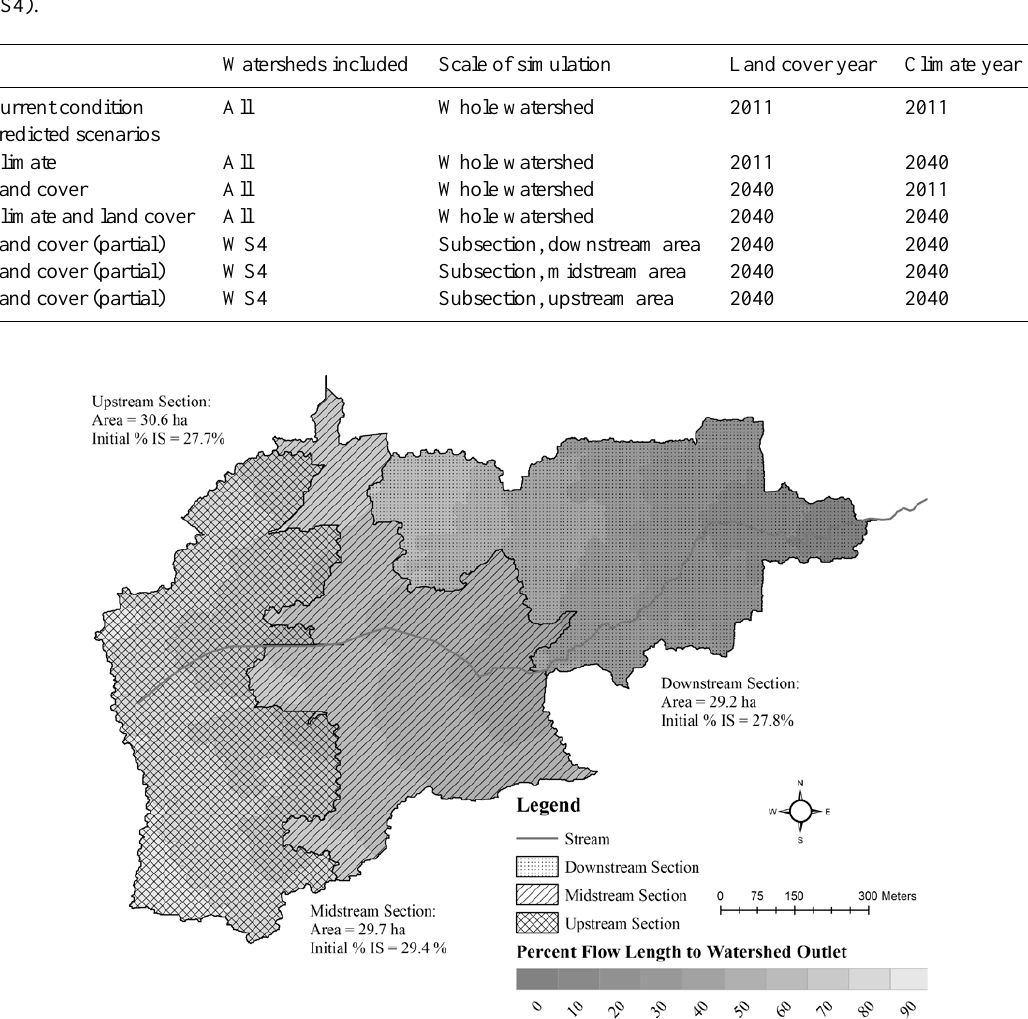
Table 2. Current and predicted scenarios for SWMM model simulation using current (2011) and future (2040) climate and land cover conditions for five watersheds in central Iowa. The different distributions of land cover change (partial) were only applied to the fourth watershed (WS4).